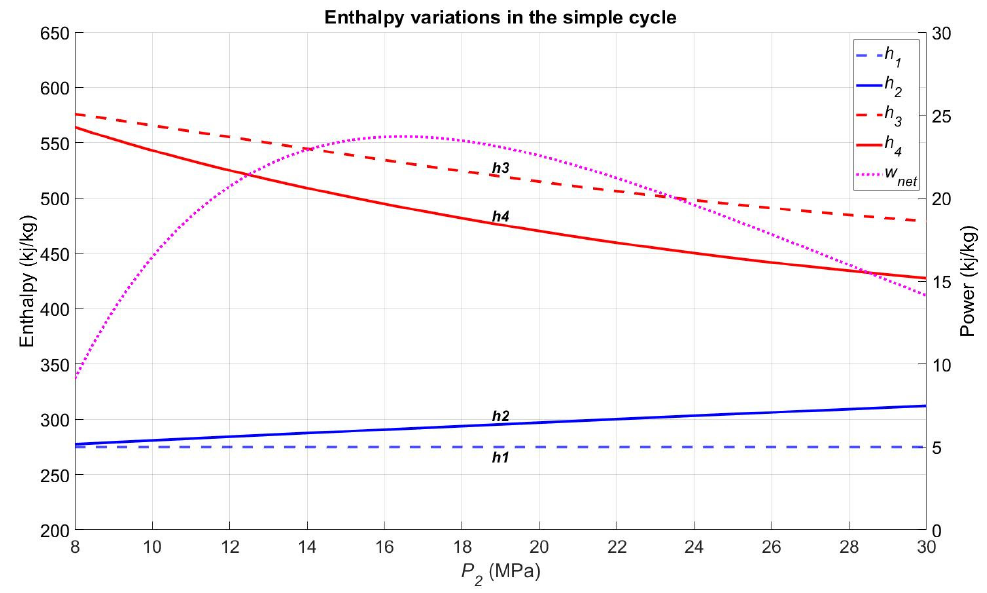
Figure 5. Enthalpy variations at each state point in the simple cycle regarding P 2 ( T h , in = 150 ◦ C; 𝜂 (cid:3043) = 𝜂 (cid:3032) = 80% ).